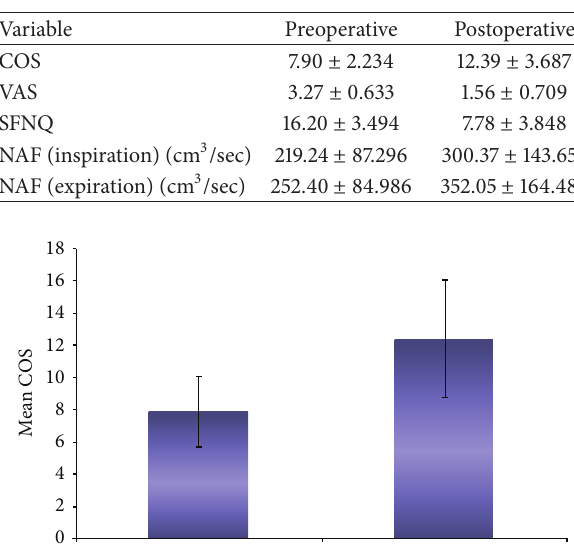
Table 1: Mean ± standard deviation of variables studied (on the obstructed side).